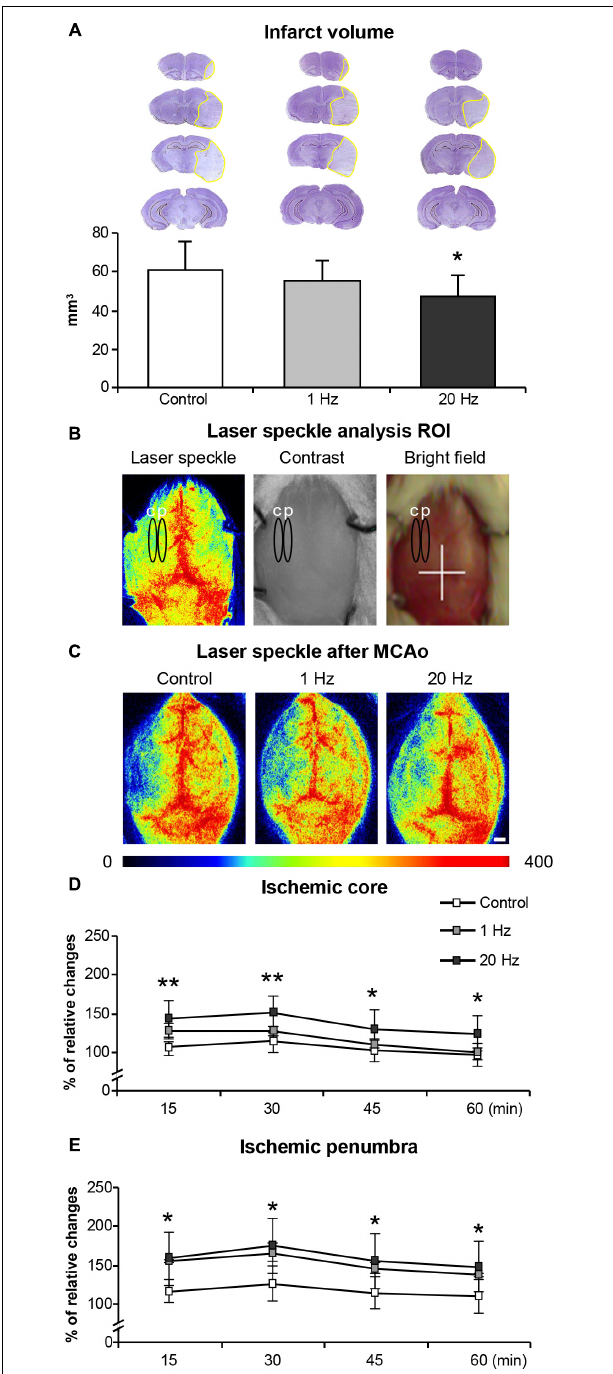
FIGURE 2 | Effects of rTMS on infarct volume and post-ischemic regional cerebral blood flow (CBF). Infarct volume (A) , laser speckle analysis ROI (B) , laser speckle images (LSI) after rTMS treatment (C) microcirculation on ischemic core (D) , and penumbra (E) . Letter c on (B) represents ischemic core area, letter p represents penumbra area. Data were evaluated by one-way ANOVA followed by LSD tests. Data are presented as mean ± SD values ( n = 8–9 mice/group for infarct volume/ n = 5/group for microcirculation analysis). ∗ p < 0.05 compared with control for (A) , ∗∗ p < 0.01/ ∗ p < 0.05 comparison between control and 20 Hz rTMS groups for (D,E)